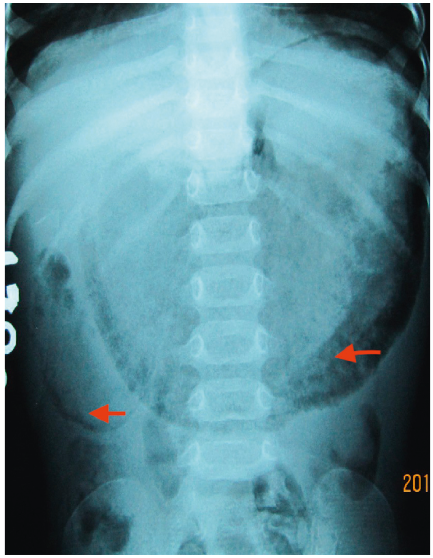
Figure 1: Plain X-ray abdomen showing gastroduodenal em- physema (red arrows).